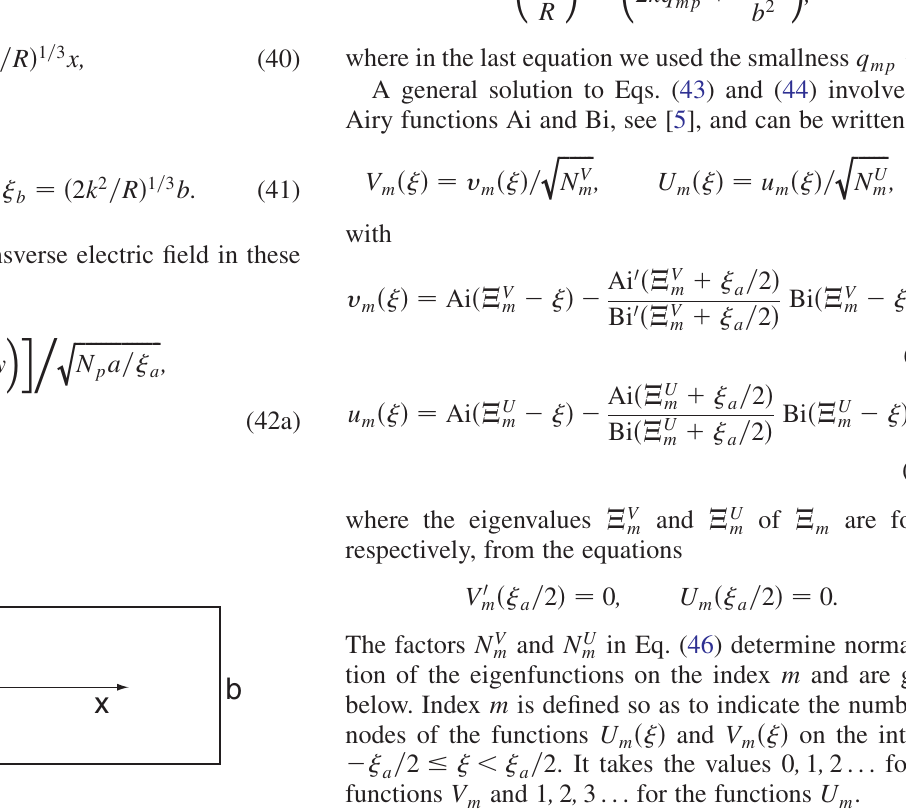
FIG. 2. Cross section of a rectangular toroidal chamber with a denoting the width in the horizontal ( x ) and b denoting the height in the vertical ( y ) directions. The origin of the coordinate system is located at the center of the